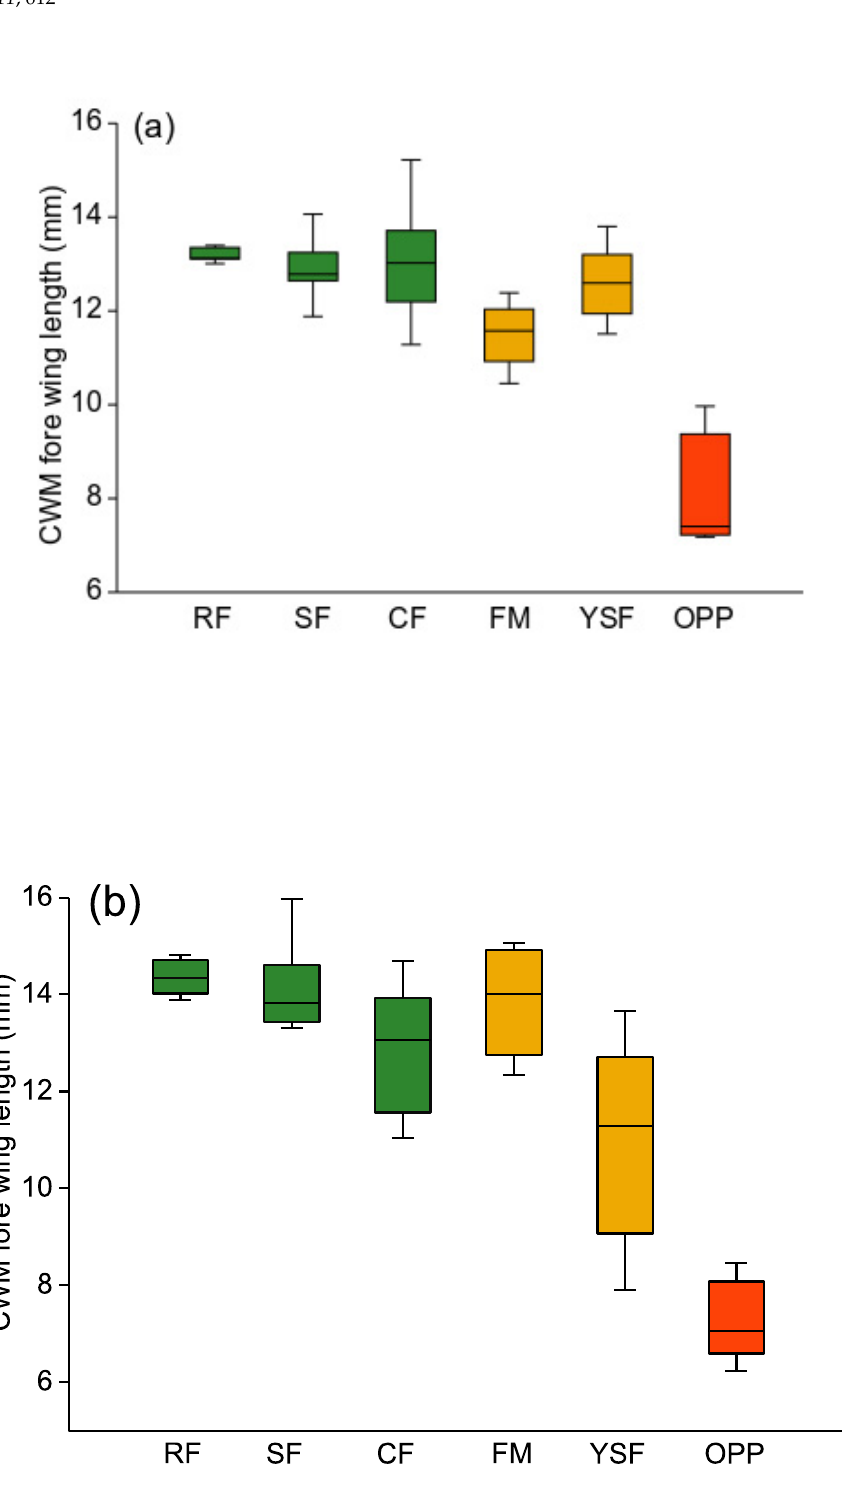
Figure 3. Box plots of community weighted means (CWM) of moth forewing length for Arctiinae ( a ) and Geometridae ( b ). Green: old-growth forest; orange: disturbed forest sites; red: oil palm plantations. RF—ridge forest; SF—slope forest; CF—creek forest; FM—forest margin; YSF—young secondary forest; OPP—oil palm plantations. Box: upper and lower quartile; horizontal line in box: median; whiskers: highest and lowest value.